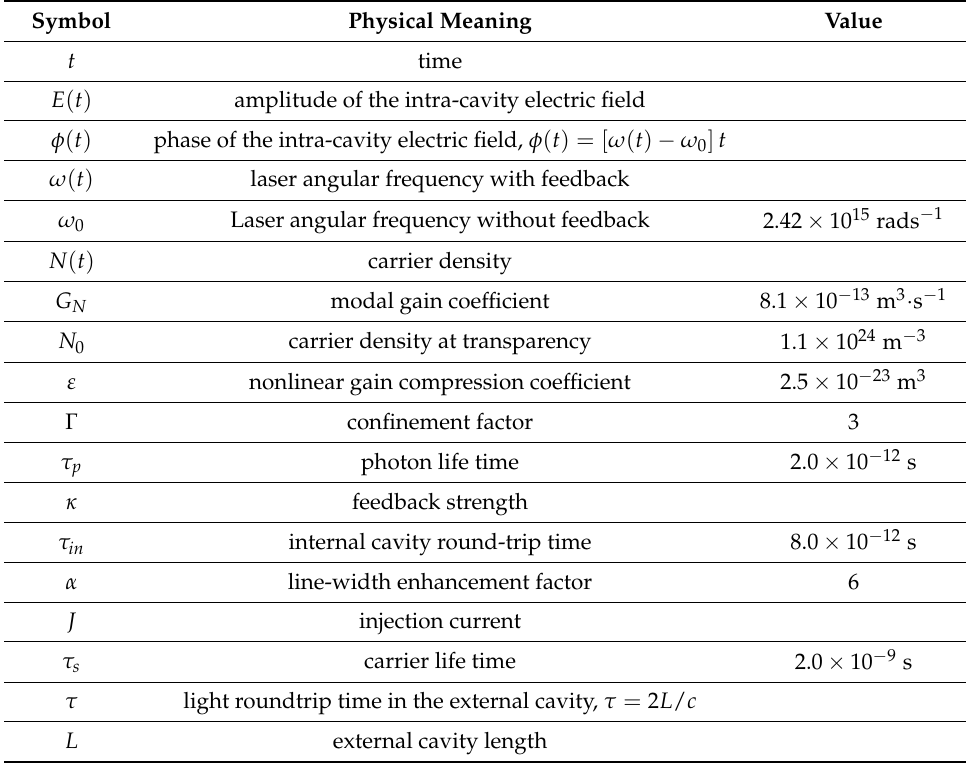
Table 1. Meanings of the symbols in the L-K